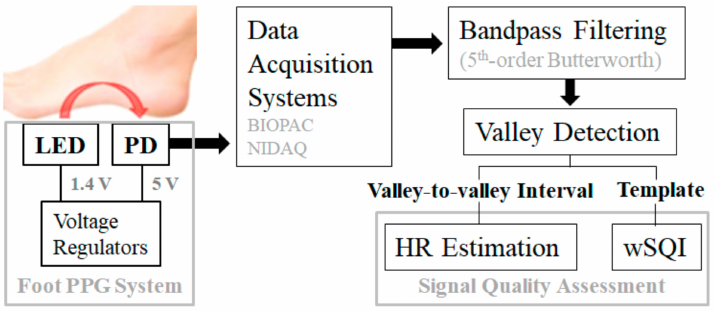
Figure 3. Process for signal quality assessments of foot